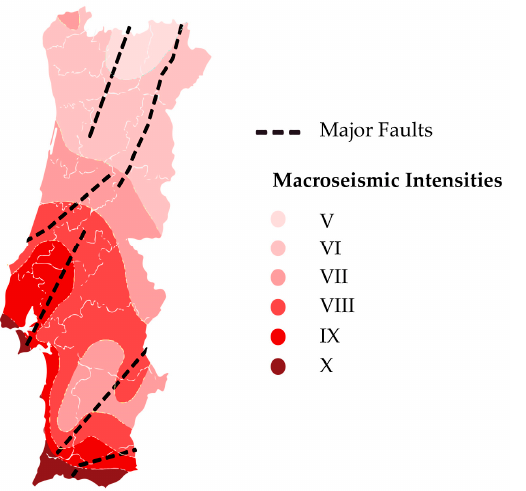
Figure 7. Map of macroseismic intensities and major faults in Portugal. Adapted from [45].